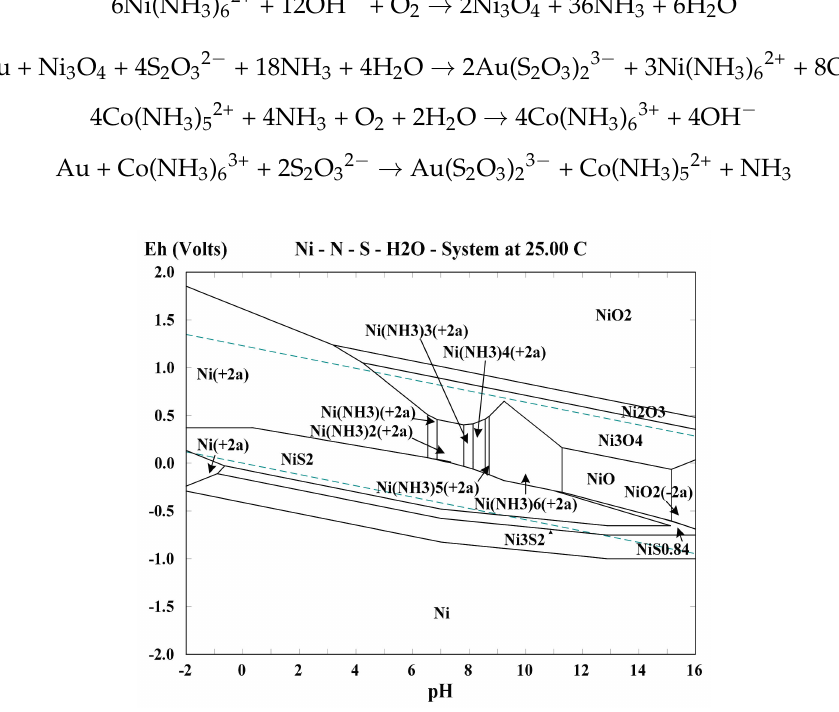
Figure 6. Eh–pH diagram of Ni–NH 3 –S 2 O 32 − –H 2 O system under the conditions of 0.05 M Ni, 1.0 M S 2 O 32 − , 1.0 M NH 3 , 25 ◦ C, and 101.3 kPa